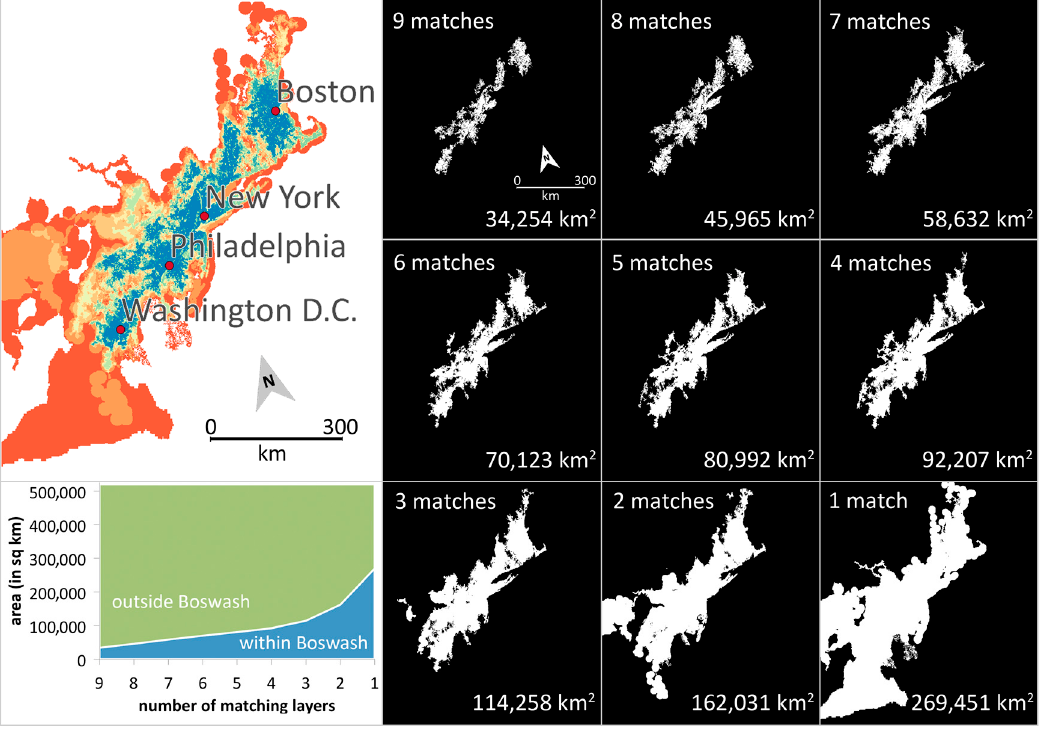
Figure 4. Top left: Probability-based flexible spatial delimitation of the Boswash urban corridor. From red to blue: Increase in layer agreement. Bottom left: Area outside and within Boswash in dependence of matching layers. Right: Different possible forms of the Boswash urban corridor in relation to the number of matching layers.